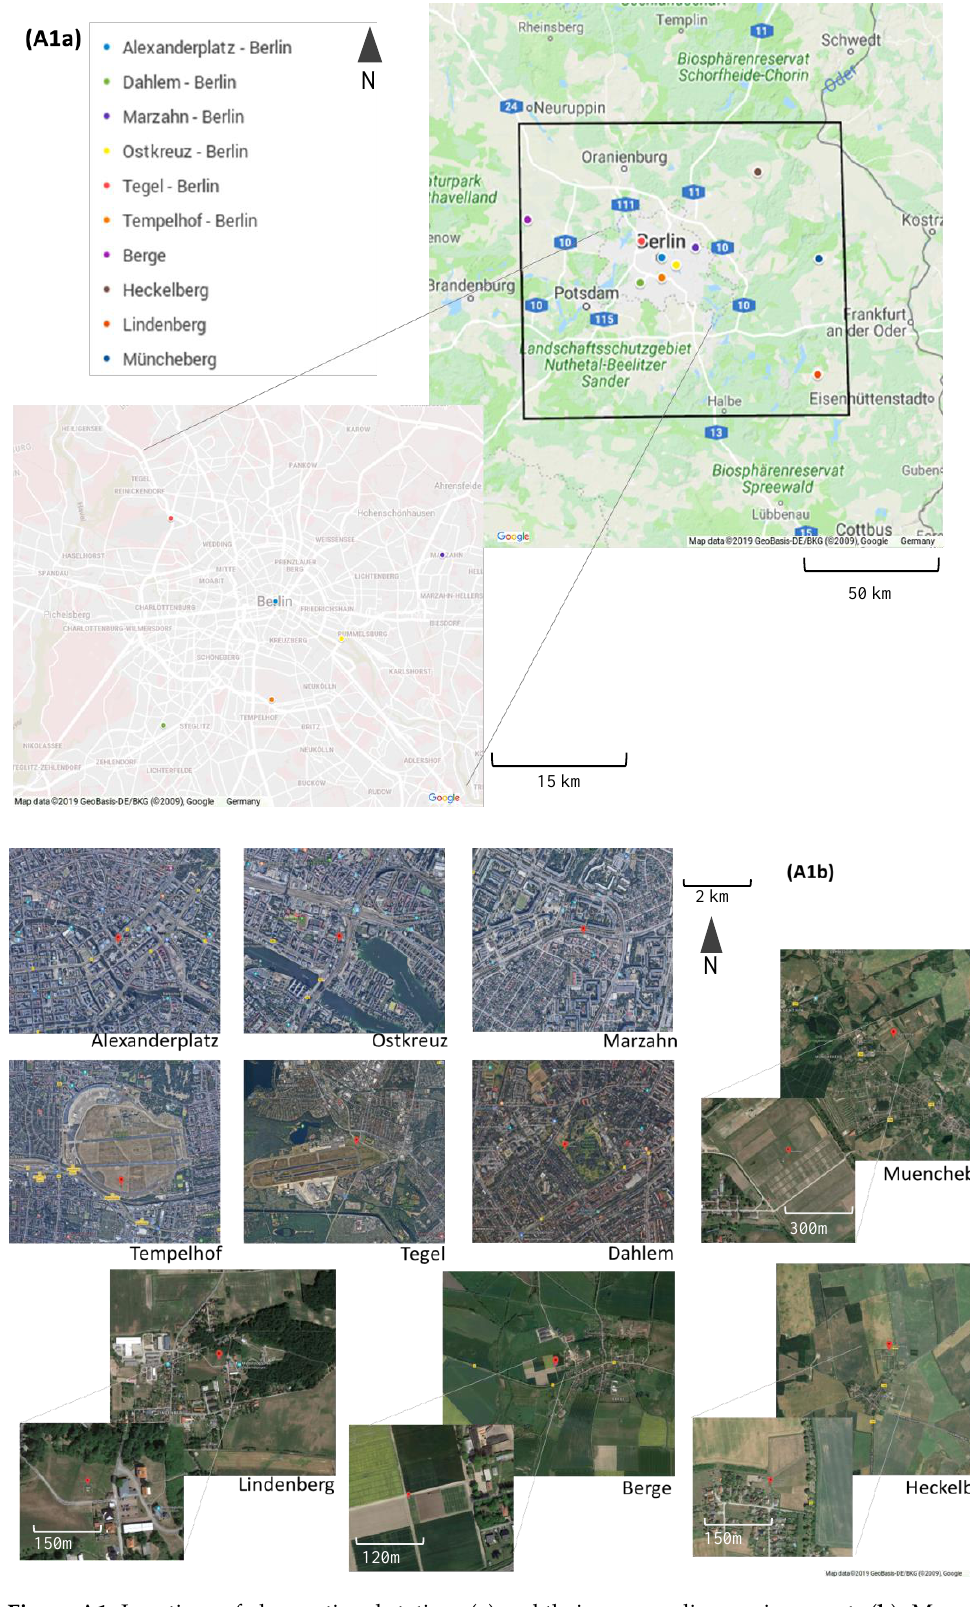
Figure A1. Locations of observational stations ( a ) and their surrounding environments ( b ). Map data from 2019 GeoBasis DE/BKG, Google, Germany.